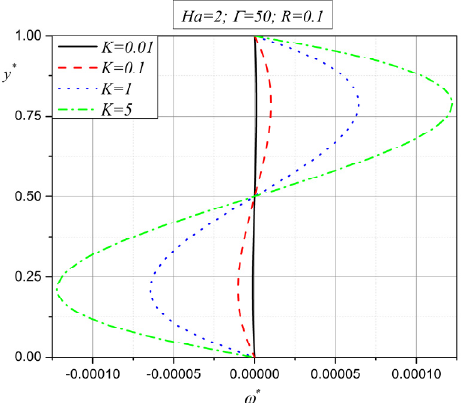
Figure 6. Influence of coupling parameter 𝐾 on microrotation 𝜔 ∗ .